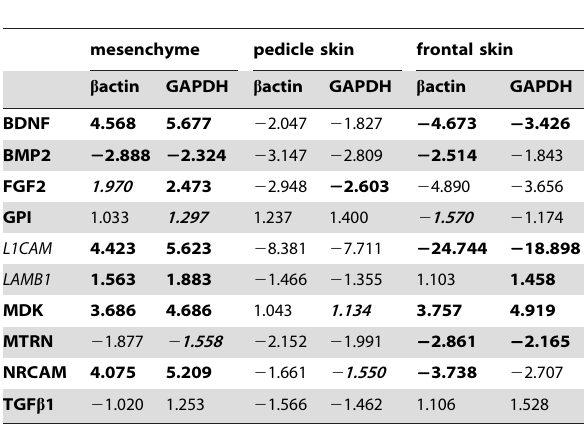
Table 4. Gene expression changes among axon growth